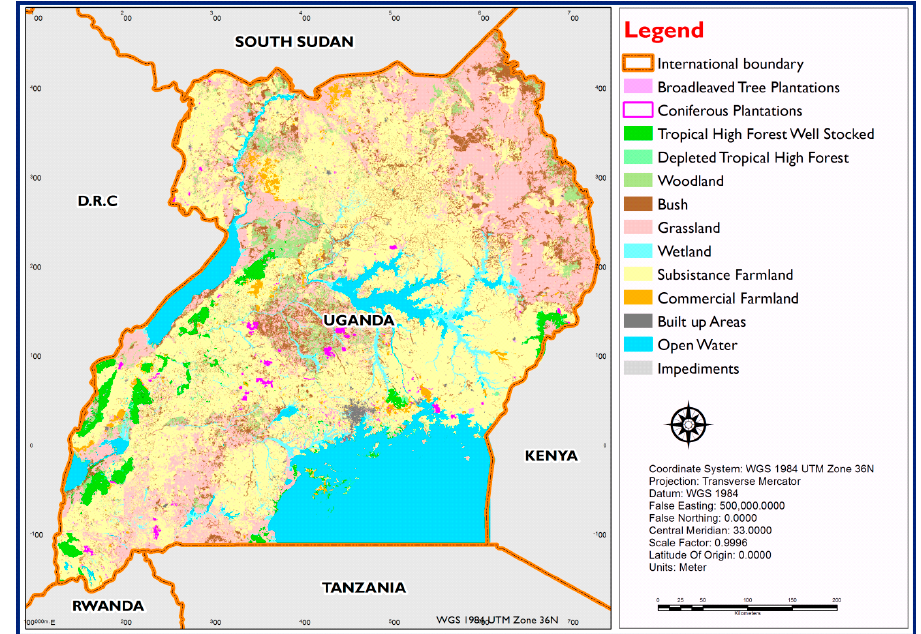
Figure 3. Land use/cover for Uganda for the year 2015.